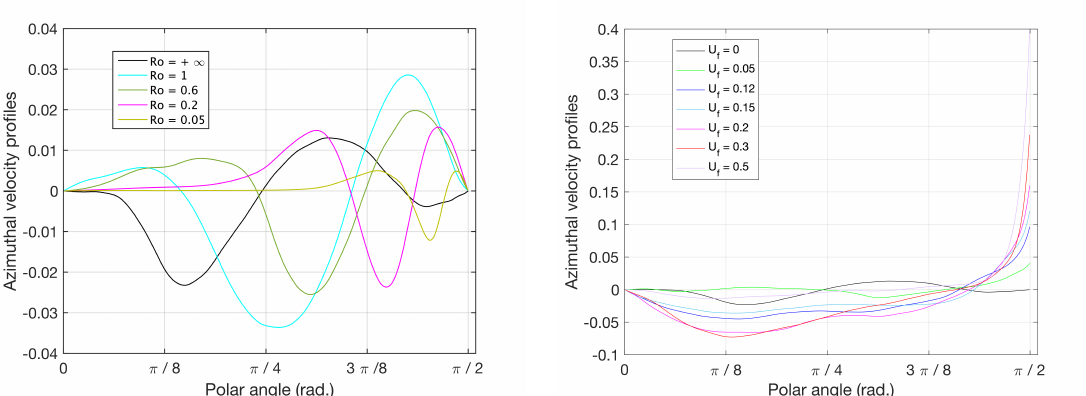
Figure 11. Azimuthal velocity profiles. Left: Method 1 for various values of the Rossby number Ro ; Right: Method 2 for various values of U f